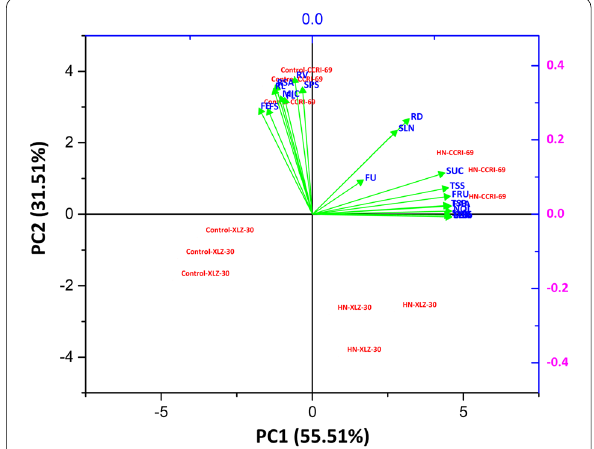
0.05. FL Fiber length ≤ =